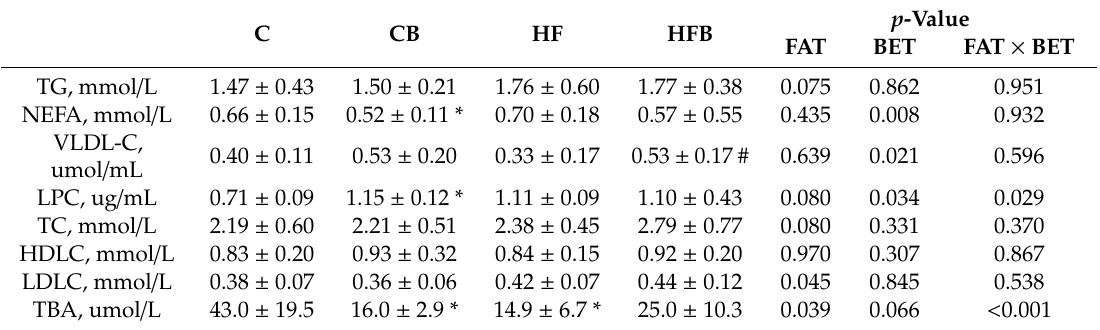
Table 4. E ff ects of betaine and high-fat diet on serum lipid metabolites of rats ( n = 8).